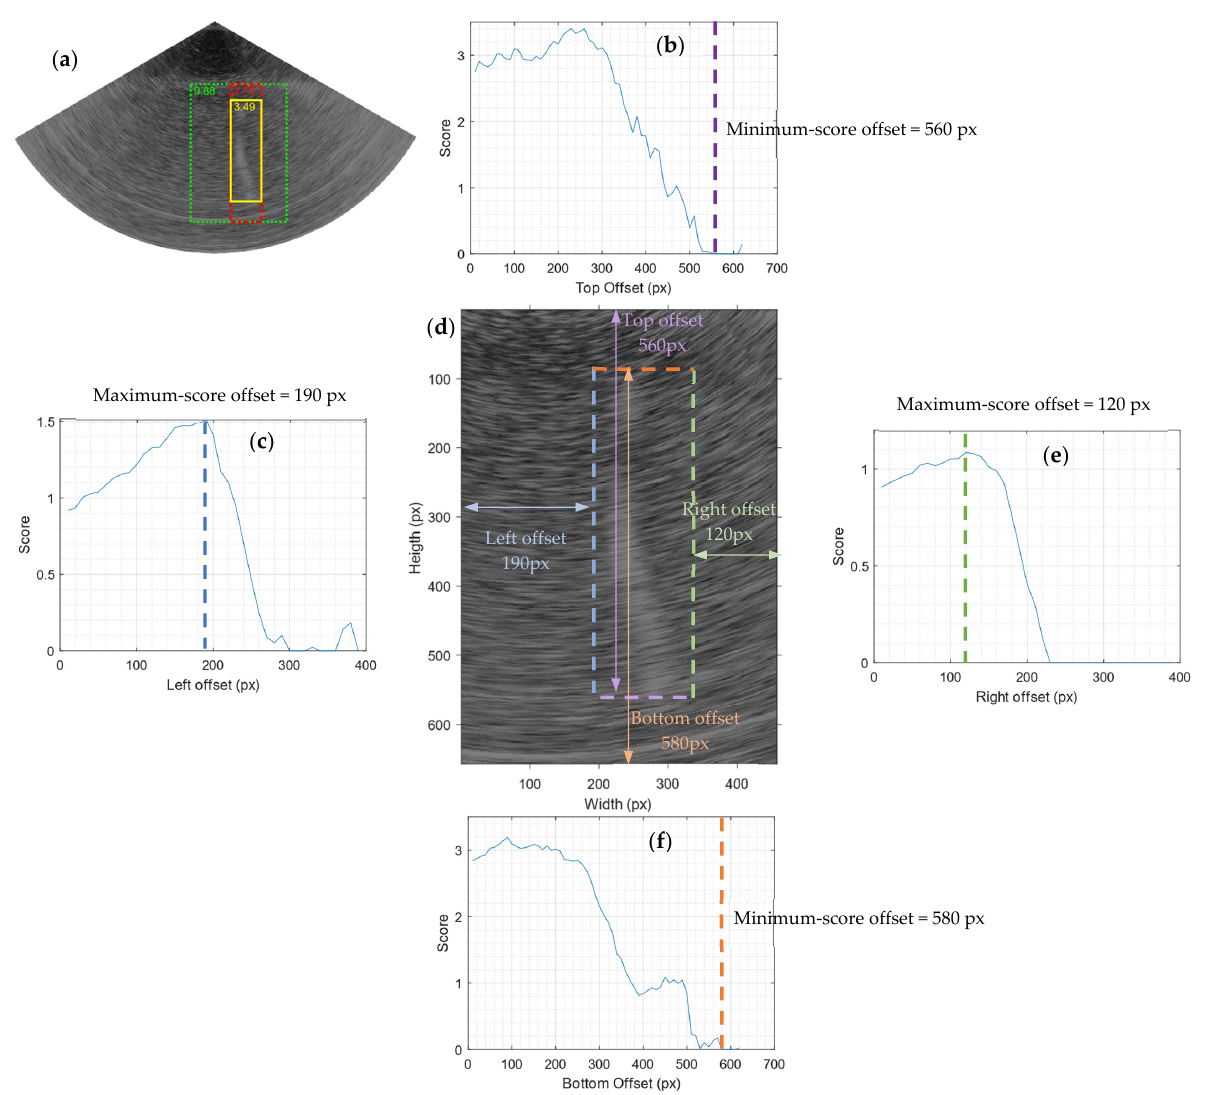
Figure 14. Precise target localization of bubble plume target: ( a ) prediction score of three detection boxes; ( b , c , e , f ) prediction score curves in left, right, top, and bottom shrinking direction; ( d ) final detection box result.